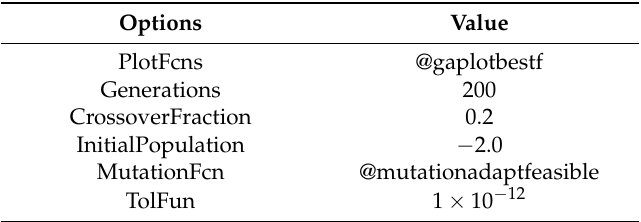
Table 1. The optional parameters of genetic algorithm function